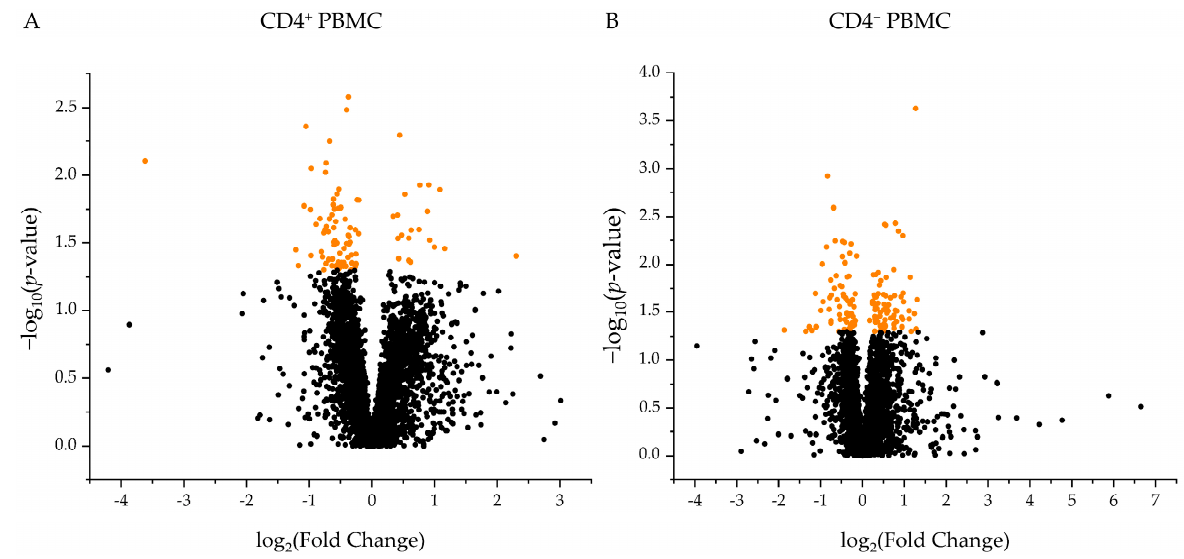
Figure 2. Volcano plot illustrating 3549 quantified proteins ( ≥ 2 unique peptides) in ( A ) CD4 + PBMCs and ( B ) CD4 − PBMCs of GHR -KO/WT pigs. Log2 abundance differences between groups ( x -axis) are plotted against log10 statistical significance values ( y -axis). Proteins that were significantly ( p ≤ 0.05) differentially abundant between WT and GHR -KO pigs are shown in orange, while proteins below the significance threshold are displayed in black.